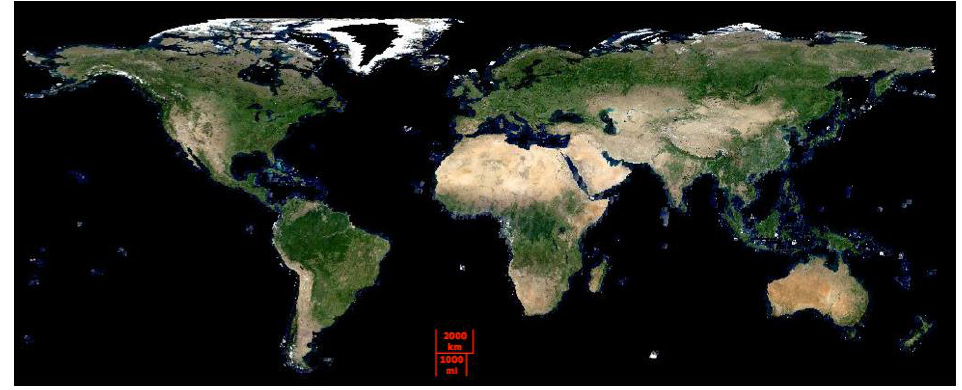
Figure 2. Global WELD (Web Enabled Landsat Data) composite for the year 2011 (December, 2010– November, 2011), a mosaic of 8003 scenes.